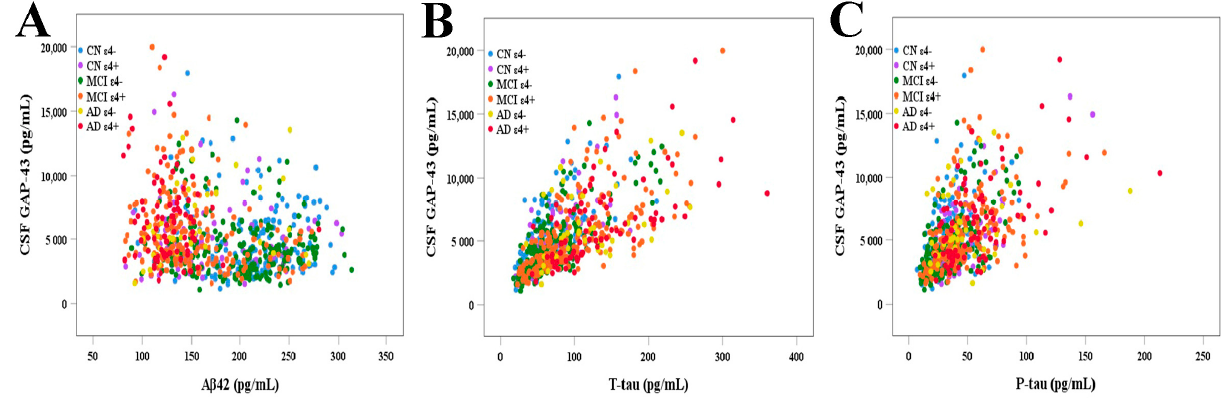
Figure 2. The correlations of CSF GAP-43 with CSF core AD biomarkers, including A β 42 ( A ), T-tau ( B ) and P-tau ( C ). CSF: cerebrospinal fluid; GAP-43: growth-associated protein 43; A β : amyloid- β ; T-tau: total tau; P-tau: phosphorylated tau; CN: cognitively normal; MCI: mild cognitive impairment; AD: Alzheimer’s disease.